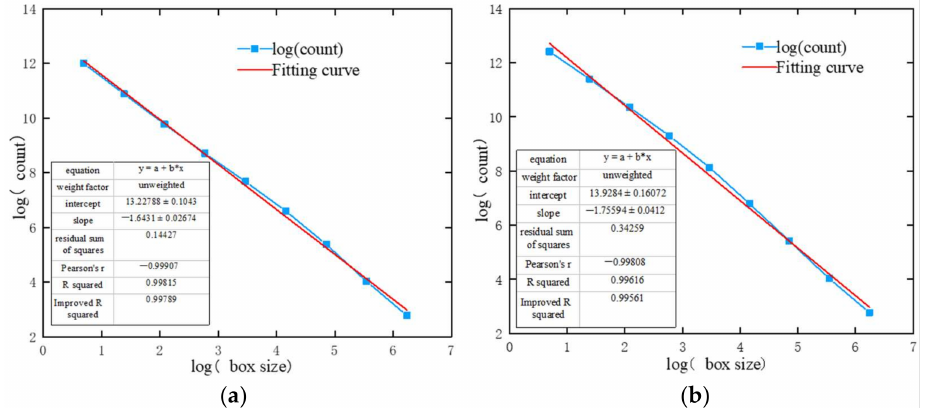
Figure 17. Calculation of fractal dimension: ( a ) Without pumping agent; ( b ) with pumping